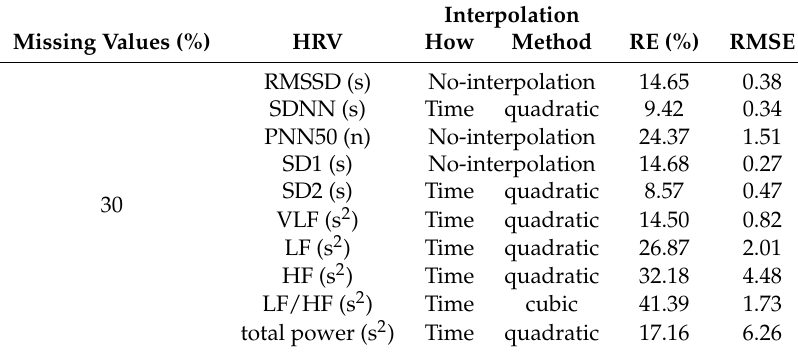
Table 3. Best performing interpolation approach (i.e., with low RE) for each HRV feature in each percentage of missing values evaluated. The error in estimating HRV features is reported using RE and root mean squared error